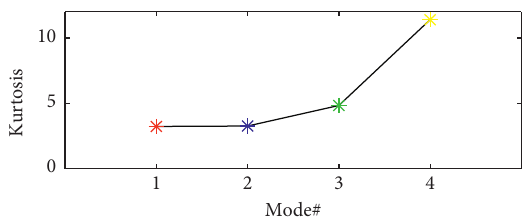
Figure 31: Kurtosis values of modes.